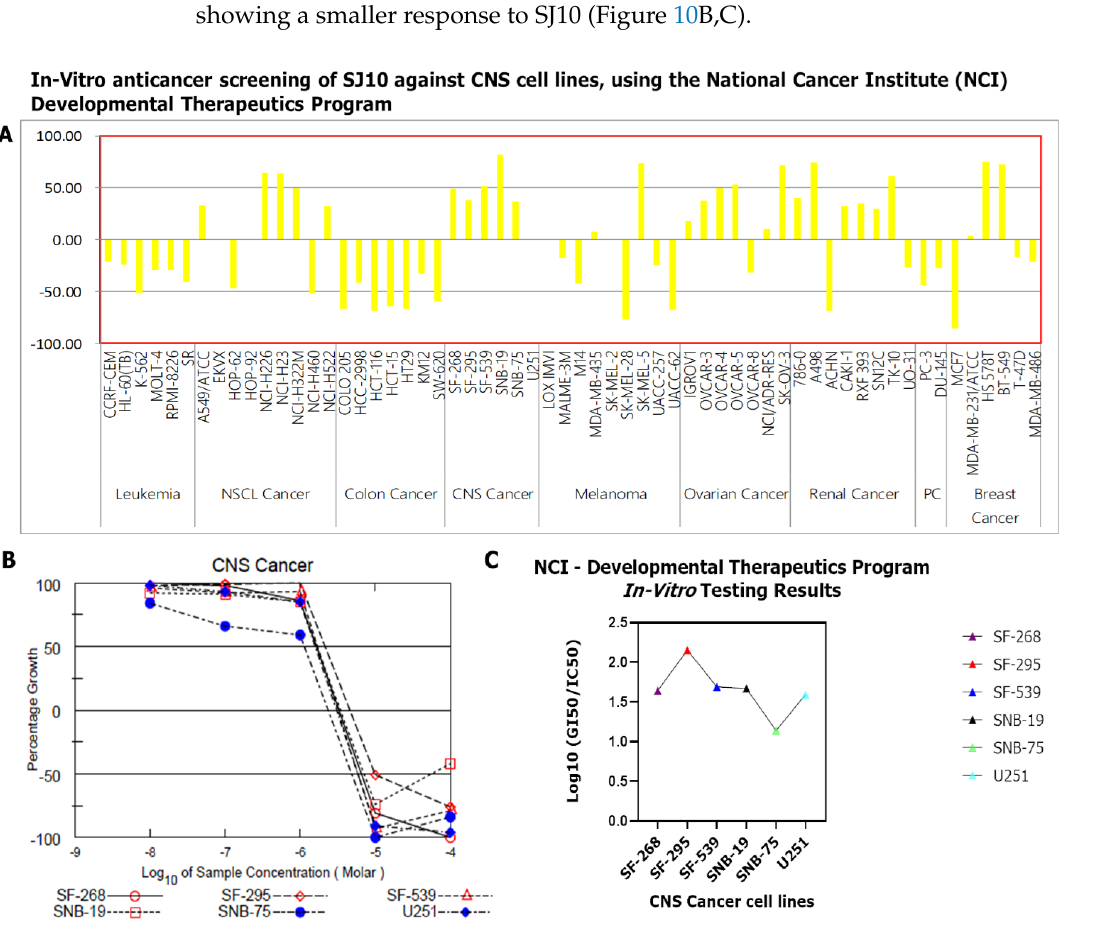
Figure 10. In vitro anticancer screening of SJ10 against NC1-60 CNS cell lines ( A ) The initial dose was 10 μM. Results showed that SJ10 exhibited antiproliferative activities against various CNS cell lines. The compound growth inhibition (GI) percentage showed that SNB-19 was more sensitive, with GI of 67.25%, followed by SF-539 at 36.91%, SF-268 at 34.33%, SF-295 at 23.75%, and SNB-75 at 22.34%. ( B ) Dose-dependent treatment results. SF-268 displayed complete growth inhibition at − 100%, followed by U251 at − 96%, SNB-75 at − 84%, SF-539 at − 79%, SF-295 at − 76%, and SNB-19 at − 42%. ( C ) SRB dual-pass staining was used to further investigate the in vitro GI 50 /IC 50 , and results ranged 1.14~2.15 μM for the CNS cell lines, with SNB - 75 cells more sensitive at 1.14 μM, followed by U251 at 1.59 μM, SF - 268 at 1.64 μM, SNB- 19 at 1.67 μM, SF - 539 at 1.69 μM, and SF -295 less responsive at 2.15 μM.